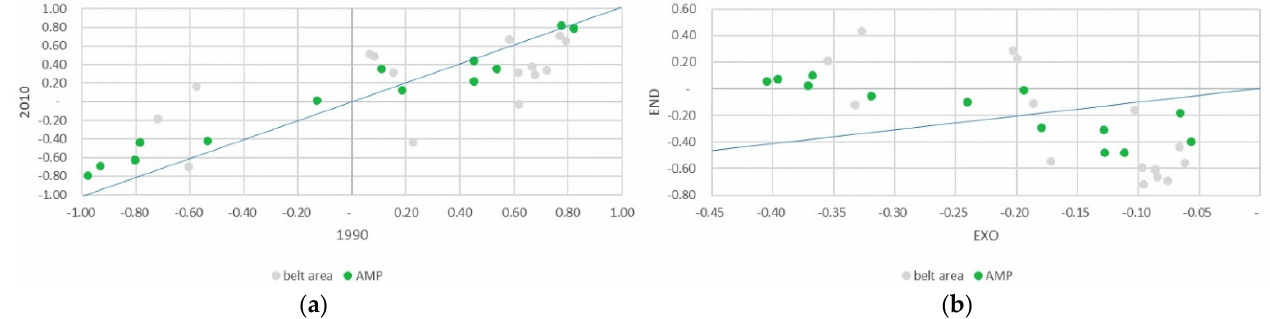
Figure 20. ( a , b ) PSI and DPSI for vines. Source: Drawn up by the authors using data provided by the ISTAT.